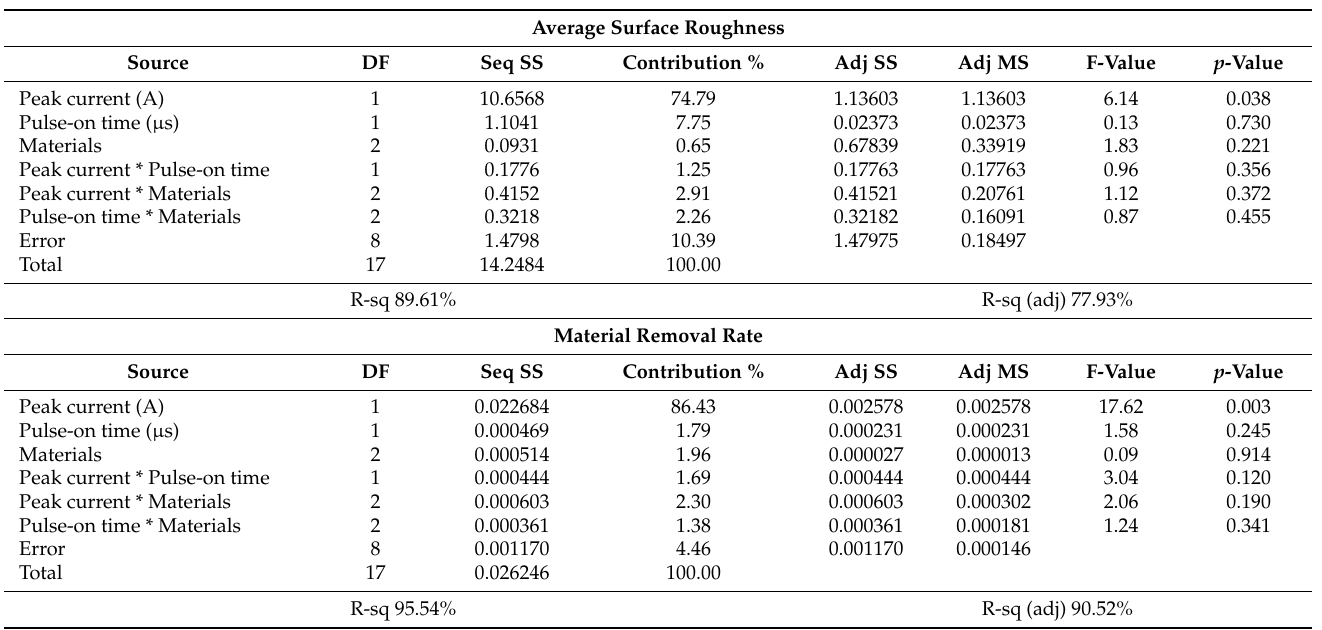
Table 9. ANOVA results for average surface roughness and